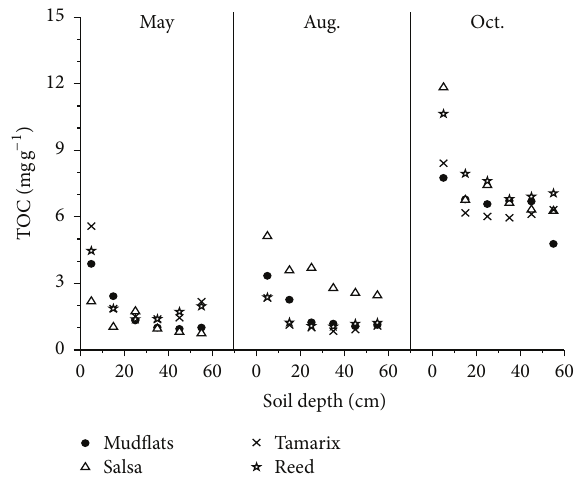
Figure4:TOCcontentsinthesoilprofileoftheYellowRiverestuary wetland. Figure 5: DOC contents in the soil profile of the Yellow River estuary